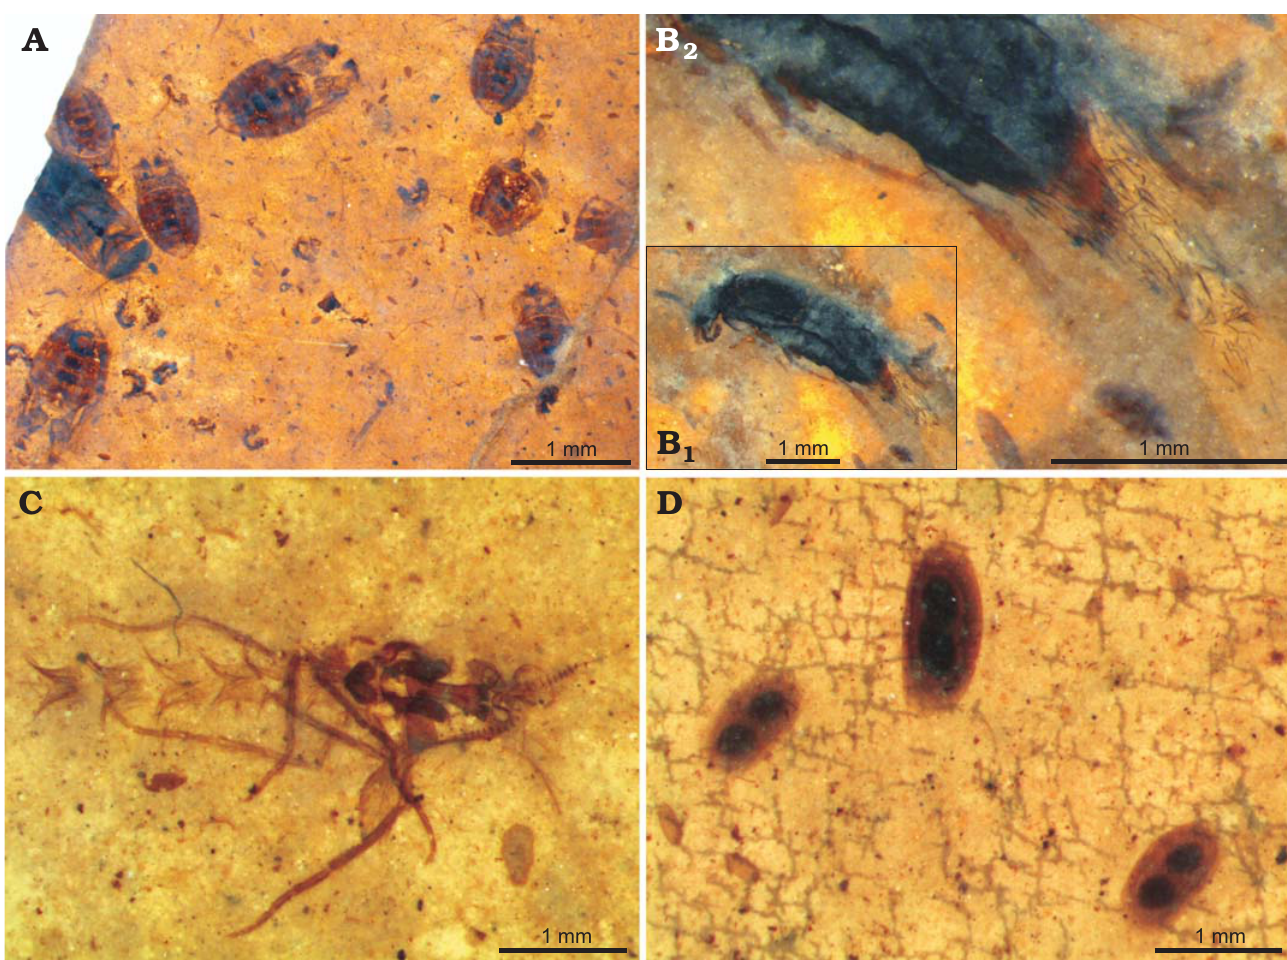
Fig. 13. Examples of preserved insect behavior with taphonomic implications in shales from the Coal Creek member of the Kishenehn Formation, Eocene, Montana, USA. A . A micrograph of an adult water boatmen (Hemiptera: Corixidae) (USNM 559597) surrounded by eight corixid nymphal exuviae on the surface of a microbial mat. B . A rove beetle (Coleoptera: Staphylinidae) (USNM 559598) within a microbial mat (B insect are swept posteriorly and numerous setae have been torn from the posterior portion of the abdomen. C . An adult midge (Diptera: Chironomidae?) (USNM 553696) in the process of emerging from its pupal exuvium (from Greenwalt and Labandeira 2013). D . Ephippia of Daphnia ( Ctenodaphnia ) sp. (USNM